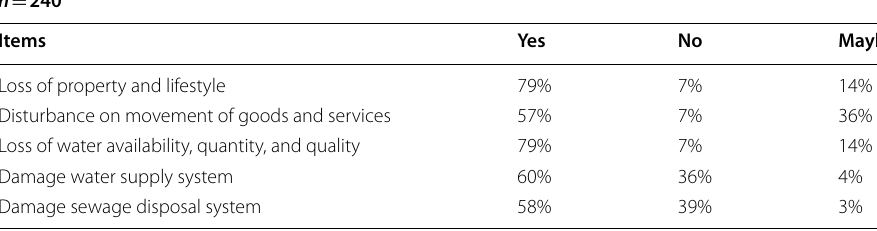
Table 1 Perception on problems after